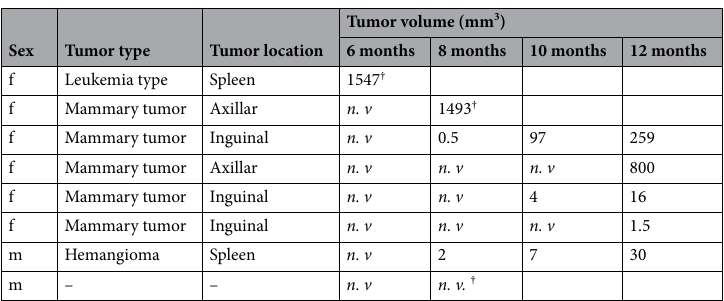
mutant females were sacrificed due to reaching humane endpoint and one mutant male was euthanized due to welfare reasons. Among the seven mutants per sex, cancerous tissue was detected on MRI in six females and one